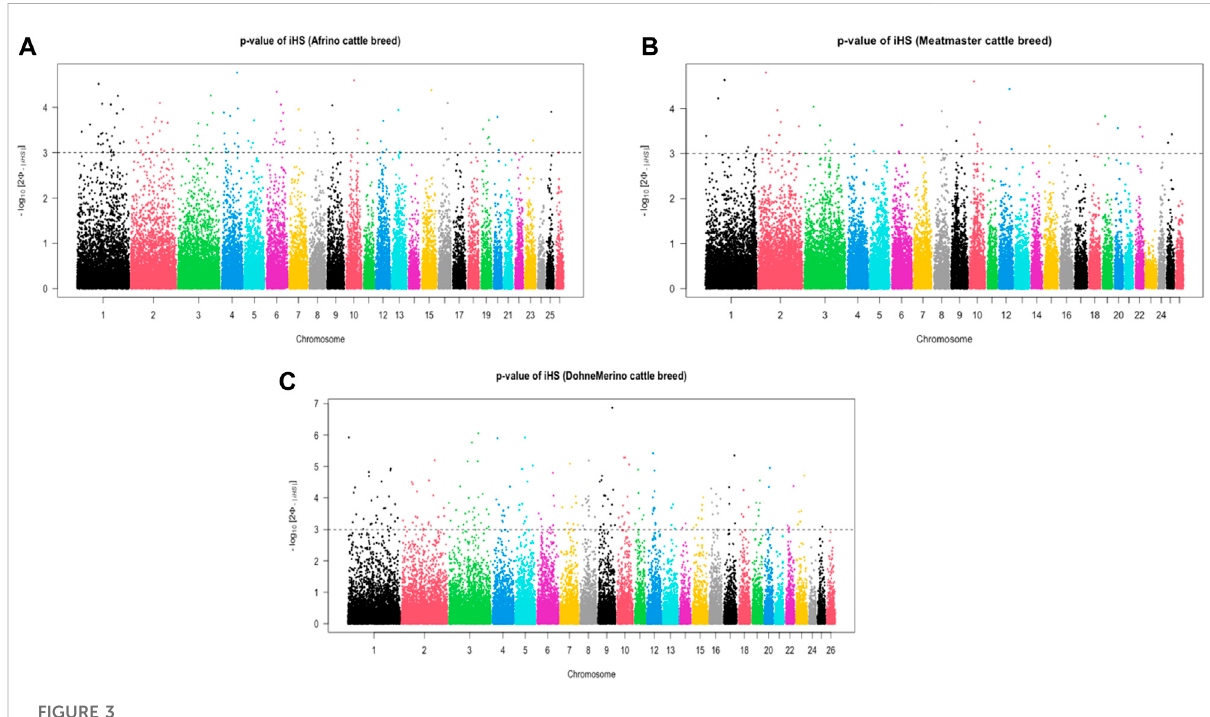
FIGURE 3 iHS scores of (A) Afrino, (B) Meatmaster, and (C) Dohne